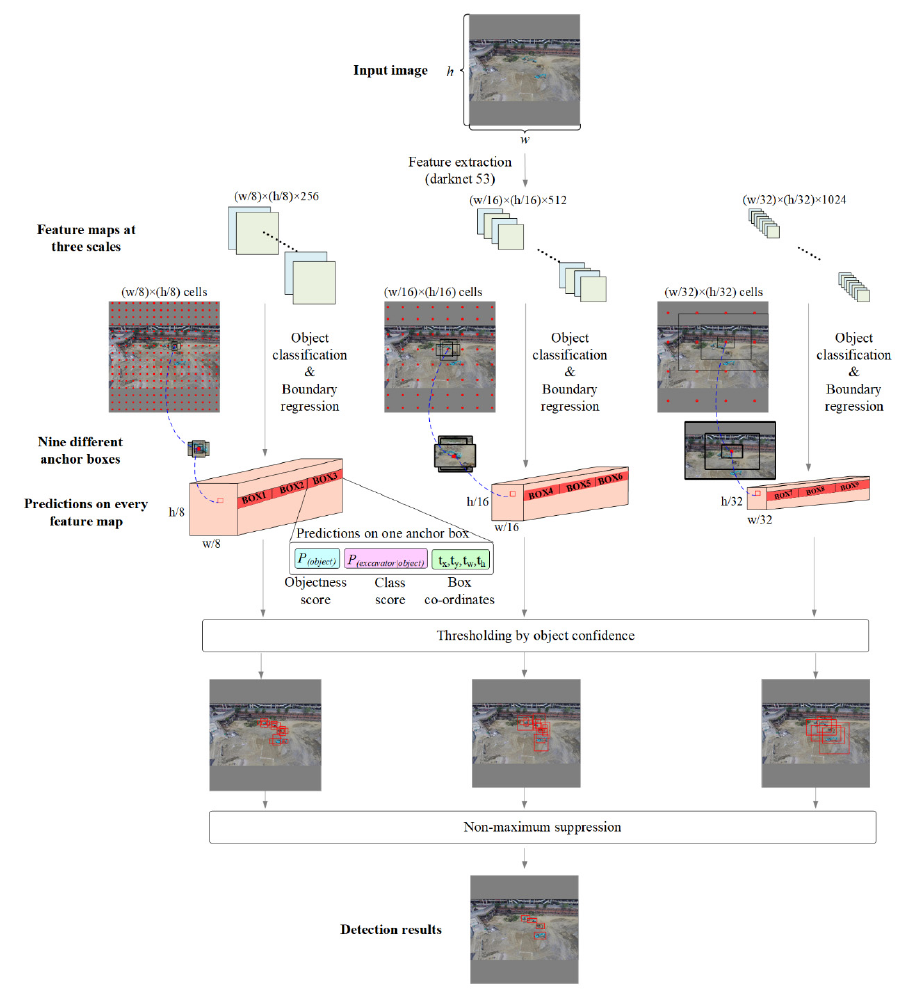
Figure 4. Flowchart of the excavator detection model. The red dot is the center of the receptive field for each cell on the original image. The red boxes are the predicted bounding boxes with confidence beyond the object score threshold (i.e., 0.5). Among them, the red boxes in the detection results are the most likely bounding boxes of the detected